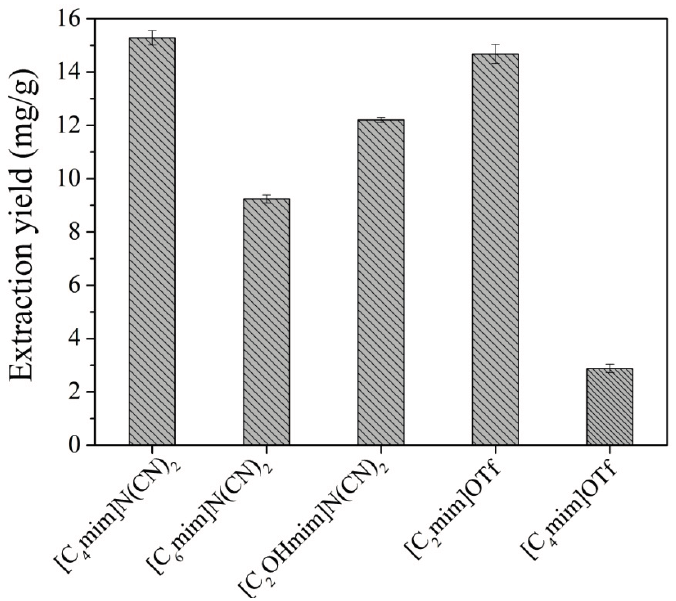
Figure 1. Ionic liquids-based ultrasound-assisted extraction of SDG using five types of